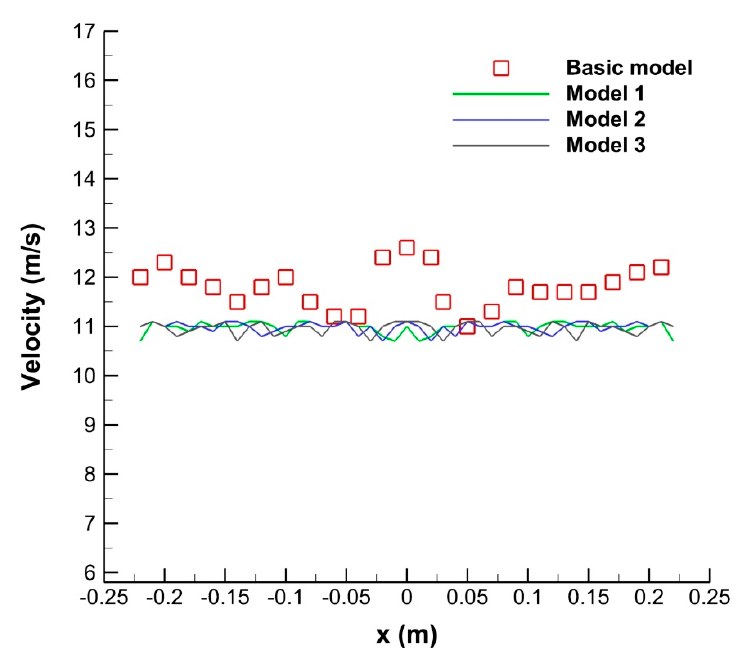
Figure 9. Exit velocity distribution along the lengthwise direction of the basic and three new gas torches.